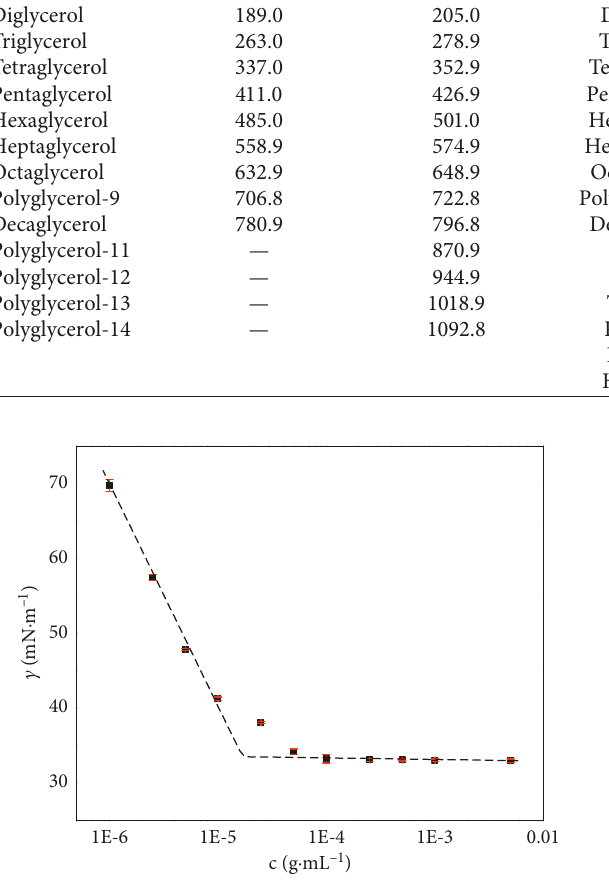
Figure 7: Plots of equilibrium surface tensions of aqueous solution of decaglycerol laurates versus mass concentration.